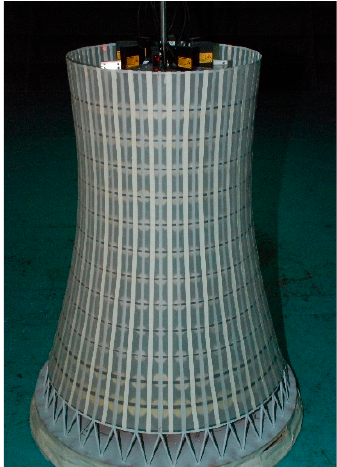
Figure 9. Aero-elastic model of Peng-cheng cooling tower for pressure measurements.